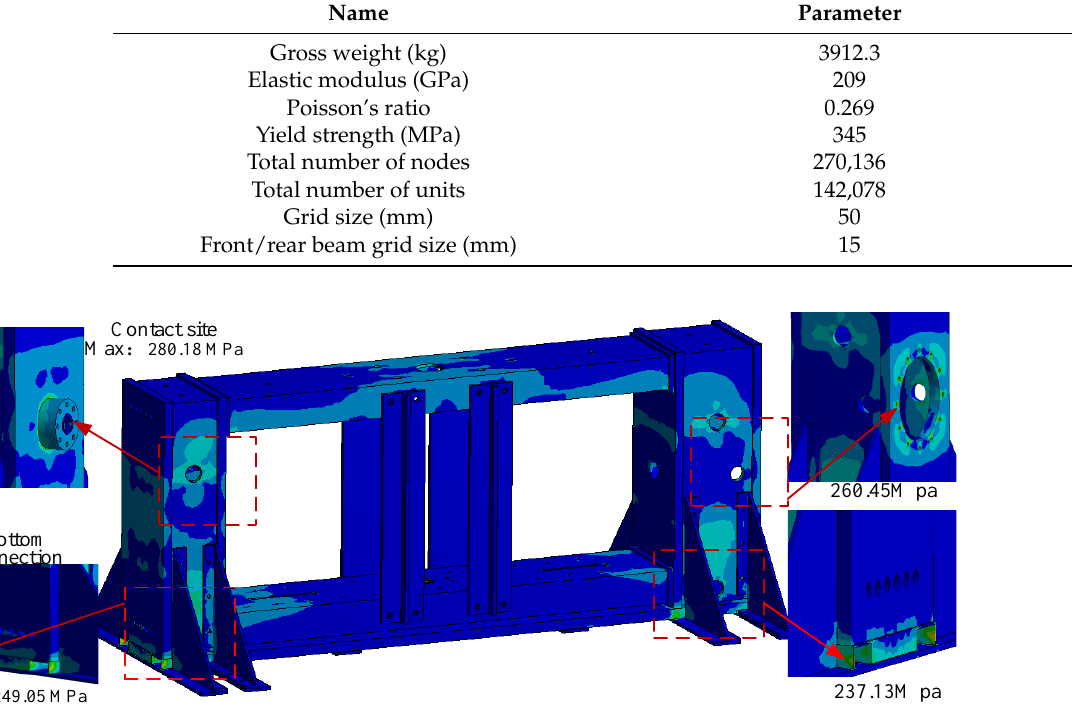
Figure 4. Displacement analysis cloud diagram of testing machine parts. 3.3. Test Control Scheme and Simulation The design scheme of the static tensile test of pultruded sheet is shown in Figure 5. The test consists of a tensile testing machine and an infrared thermal imaging test sys- tem. The control system of the testing machine is composed of the actuator, the lower computer, the upper computer, and the data acquisition system. The host computer is written in LabVIEW language, and the overall control of the platform is carried out through the PC terminal. The upper computer has the functions of programming the control algorithm, collecting data, storing and displaying the strain curve. The lower computer is composed of PLC and RMC in parallel, in which PLC obtains signals such as force sensor, oil temperature sensor and liquid level sensor. RMC control electro- hydraulic servo valve has the advantages of fast response speed, high control precision and good dynamic performance. The execution structure adopts the MOOG servo valve,